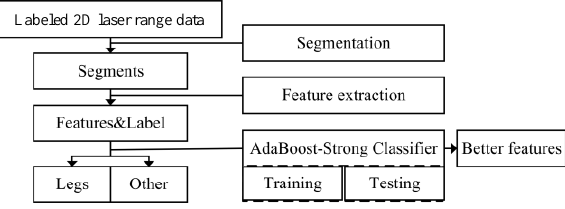
Figure 1. The overall workflow of our